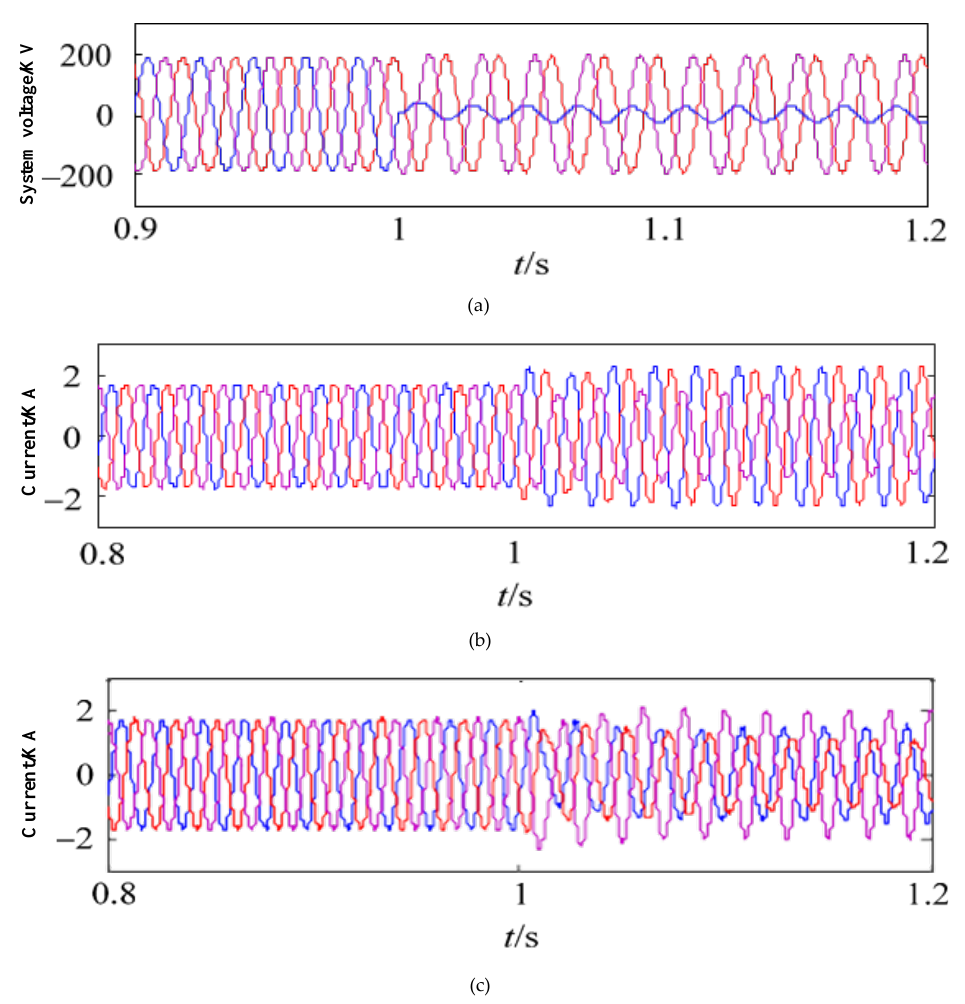
Figure 6. Main transformer low-voltage fault waveforms analysis: ( a ) suppressing the negative sequence current, ( b ) suppressing active fluctuations, ( c ) suppressing reactive power fluctuations.